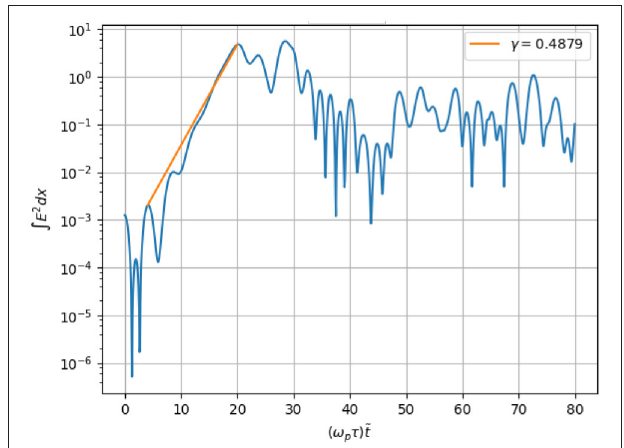
FIGURE 3 | Evaluation of electric field energy for the two-stream instability problem. A growth rate of 0.4879 is measured, compared with the theoretical rate of